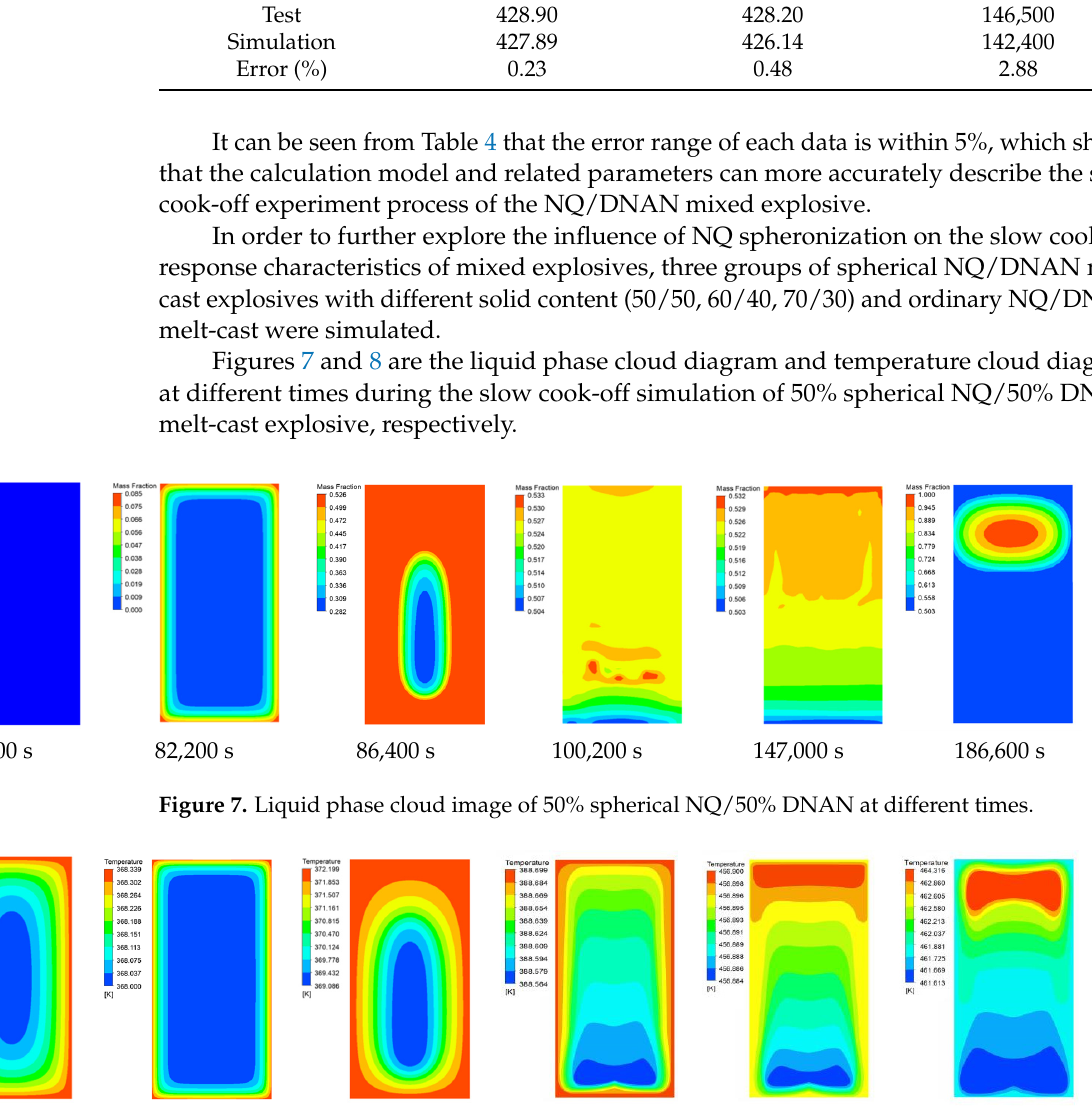
Table 4. Comparison of experimental results and simulation results.